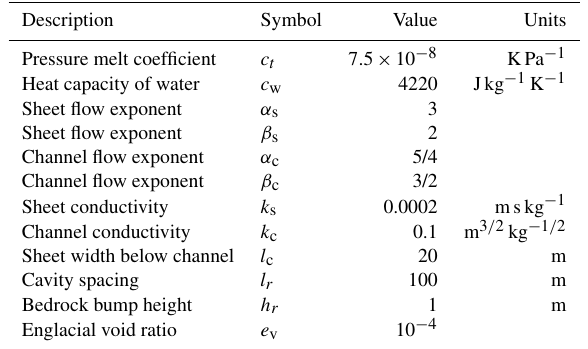
Table 1. Parameters used in GlaDS model for all model runs in this